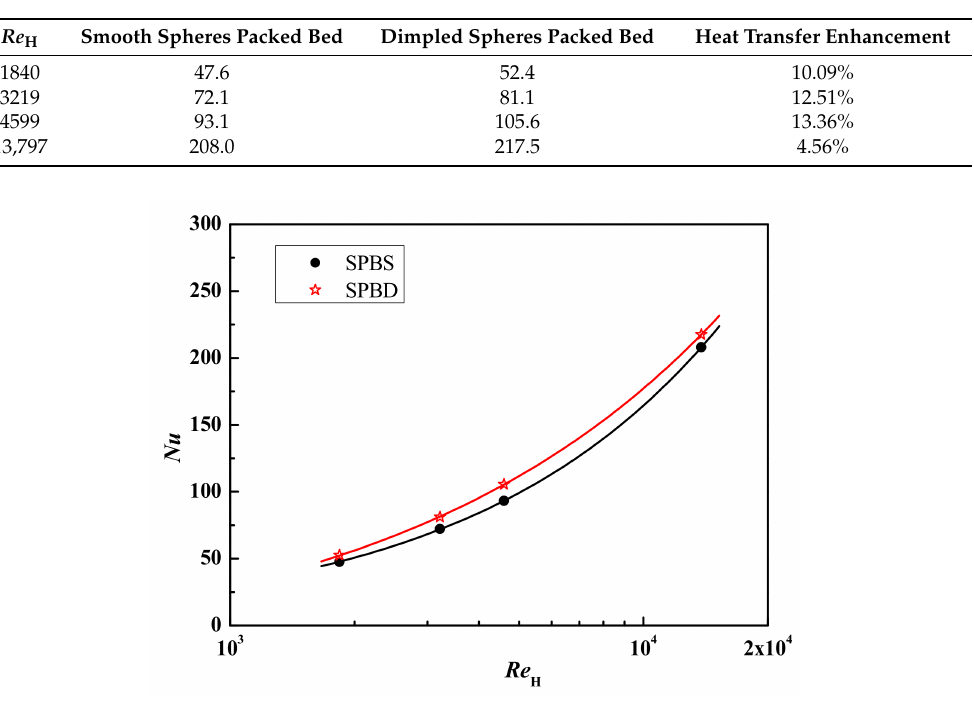
Figure 16. The Nusselt number of the structured packed bed with smooth or dimpled spheres at N =